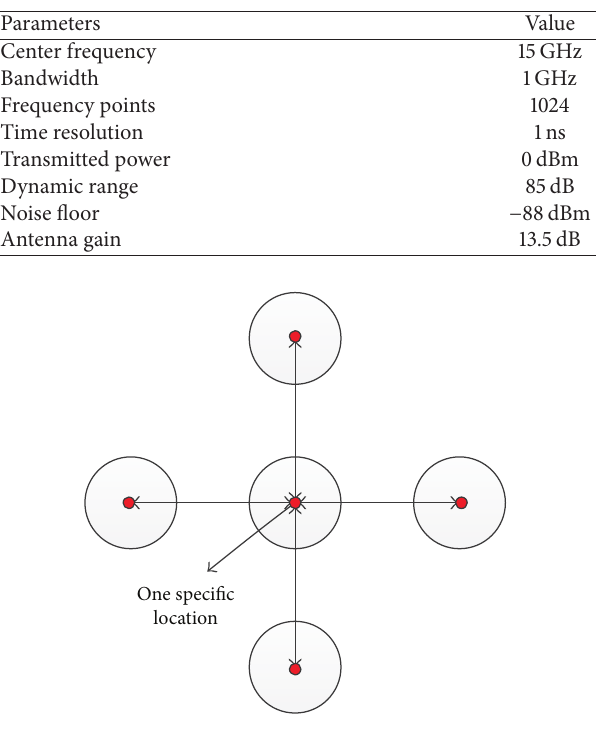
Figure 2: Positions of Rx at each location. One received point is at the center of one specific location, surrounded by the other four